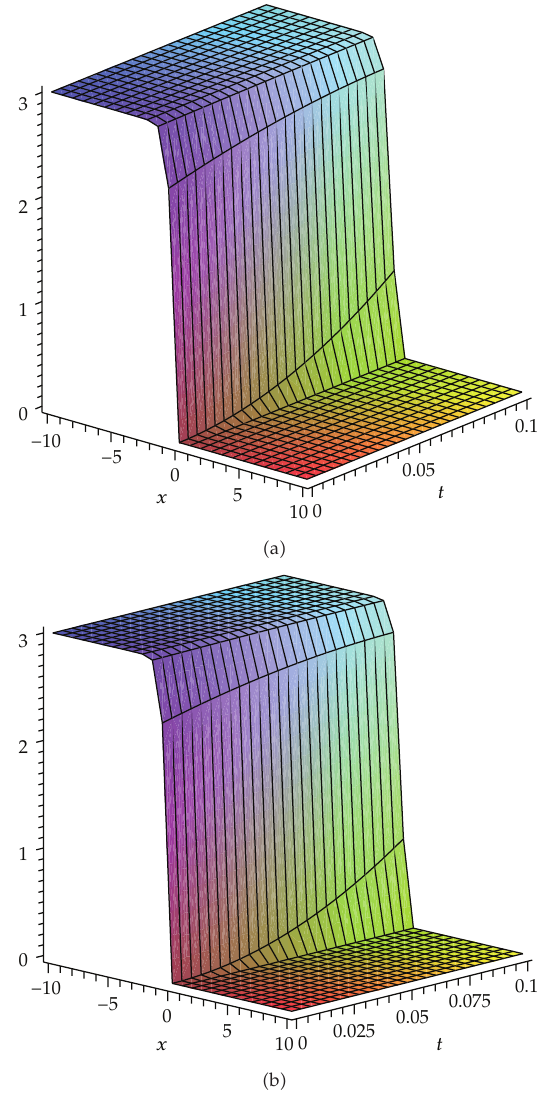
Figure 4: The solution of (cid:3) 1.1 (cid:4) at c (cid:9) 3 (cid:3) a (cid:4) HPM (cid:3) b (cid:4)